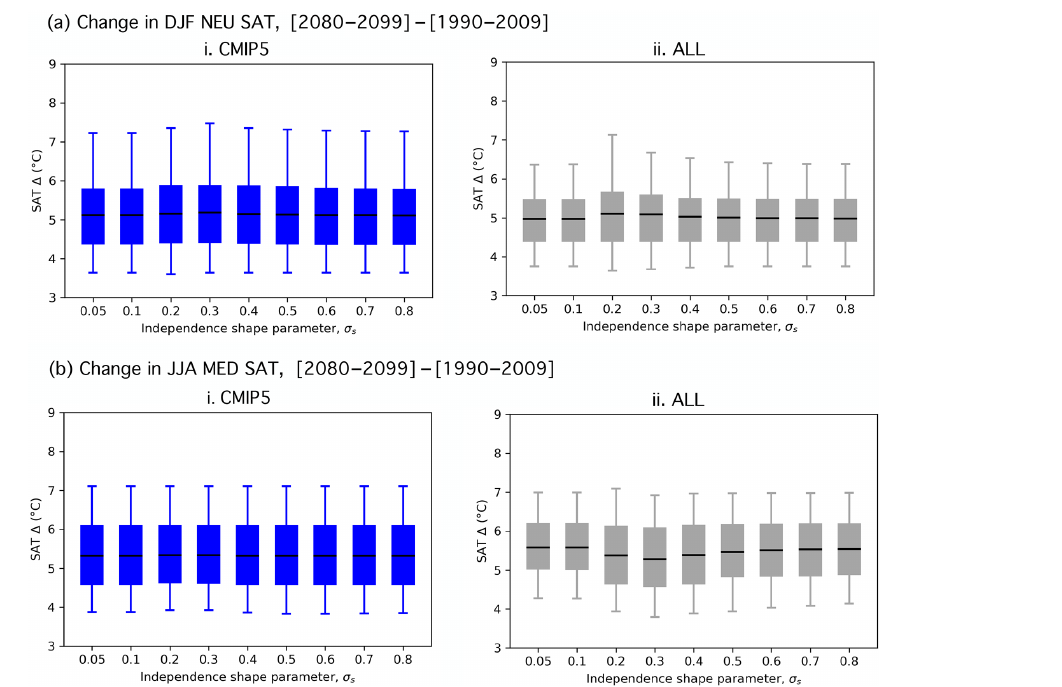
Figure B3. The σ S sensitivity of the nine-predictor RMSE weightings in Fig. 3; σ S used for each weighting is indicated below each box element. Box-and-whisker plots show the SAT change distribution under the RMSE independence scaling weighting assumption ( (cid:49) , (2080– 2099)–(1990–2009)) for the CMIP5 ensemble (i; blue) and ALL ensemble (ii; gray). The box element spans the 25th to 75th percentile of the distribution; mean SAT change is indicated by the horizontal line within the box. The whisker element spans the 5th to 95th percentile. DJF NEU SAT change is shown in (a) , and JJA MED SAT change is shown (b)